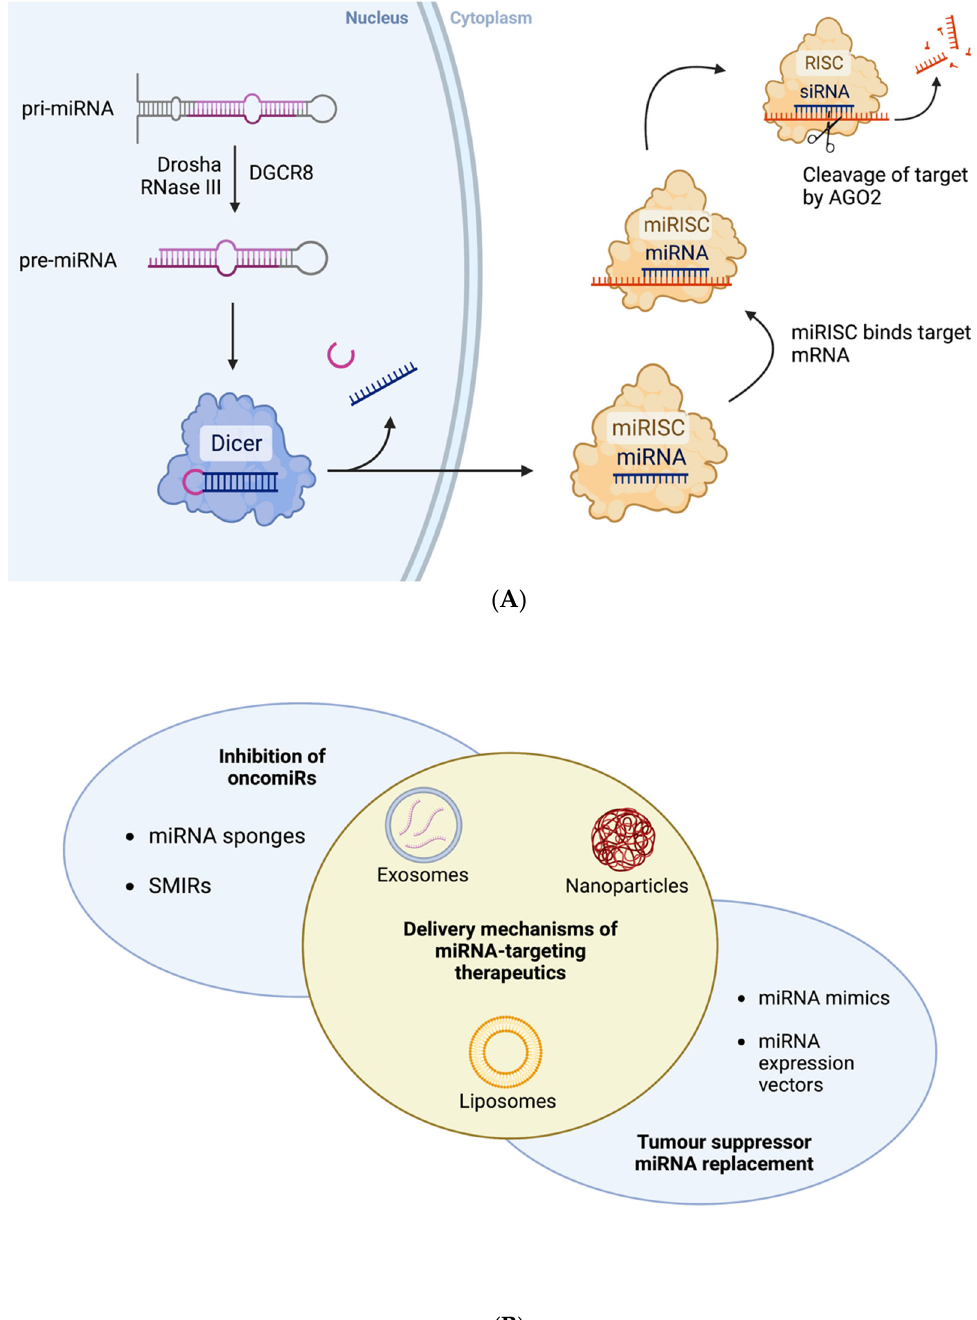
Figure 1. ( A ) Schematic of normal biogenesis and function of miRNAs. ( B ) Summary of miRNA-based therapeutic strategies and mechanisms of delivery to cells. Created with BioRender.com.